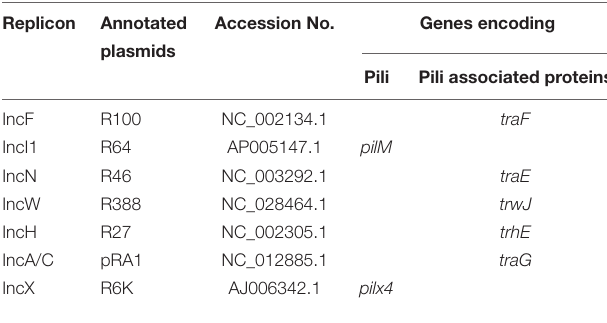
TABLE 4 | Pili and pili associated genes in annotated plasmids assigned to specific plasmid replicon types. Replicon Annotated Accession